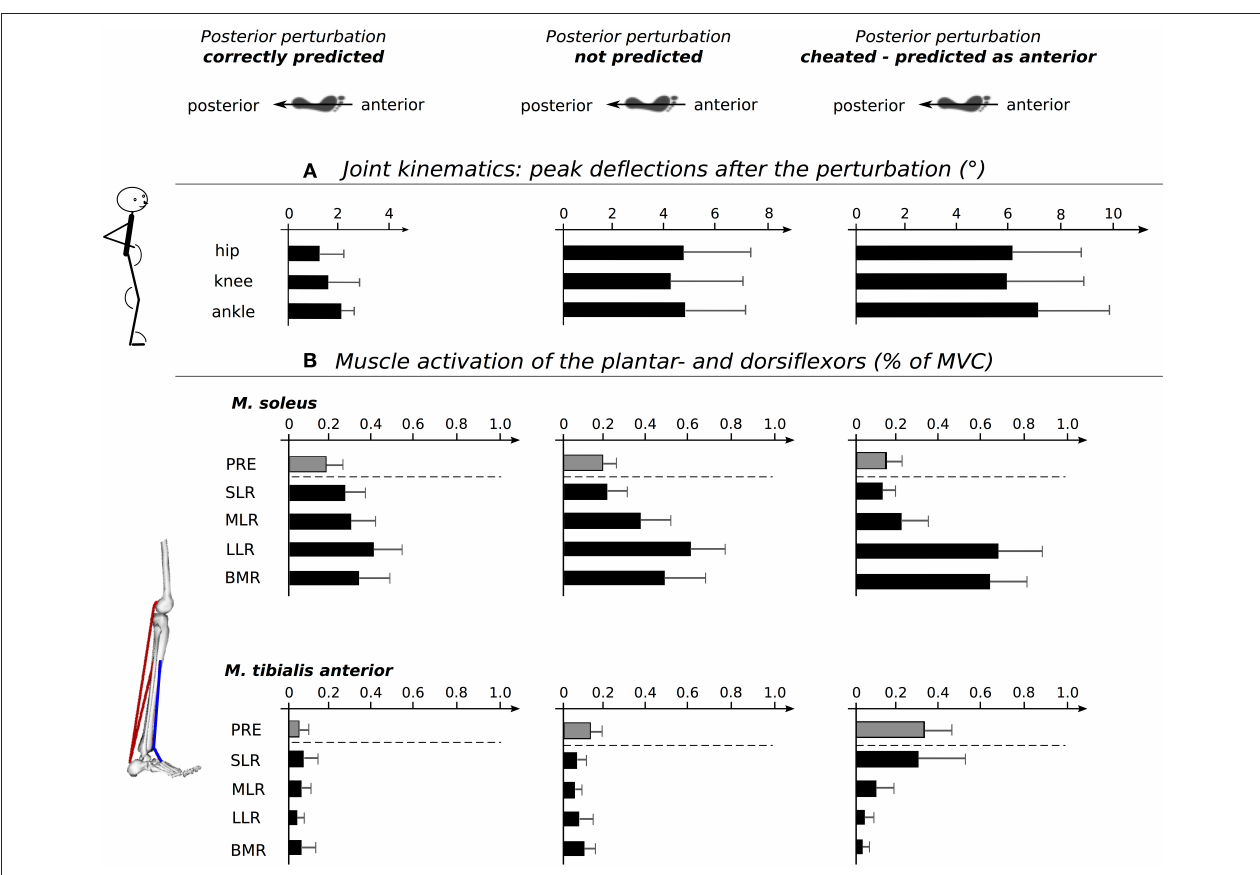
FIGURE 3 | Schemes show the postural set at perturbation onset with respect to predicted (left), unpredicted (middle) and cheated (right) perturbations Below, diagrams showing peak deflections at ankle, knee and hip joints (A) . Note that the joint excursions increase from predicted to unpredicted to cheated perturbations. (B) Diagrams illustrating the changes in the plantar- and dorsiflexor neuromuscular activation intensities for the distinct time periods before and after perturbation: pre-activation (PRE, gray), short- (SLR), medium- (MLR), and long latency response (LLR), as well as the belated muscle response (BMR, all in black). The dotted line separates the proactive changes prior to perturbation from the reactive changes after the perturbation. Anticipation-induced changes are manifested for neuromuscular control of antagonists encompassing the ankle joint prior and after perturbation. Statistical results are presented in Tables 1 , 2